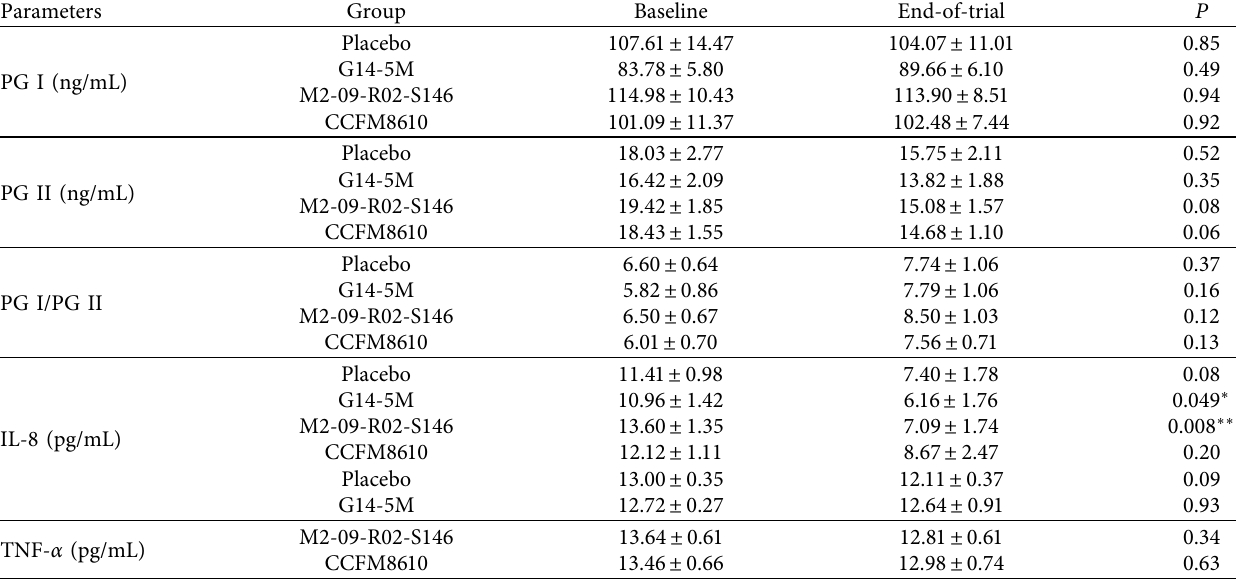
Table 4: Effects of Lactobacillus strain consumption on serum concentrations of pepsinogens and inflammatory